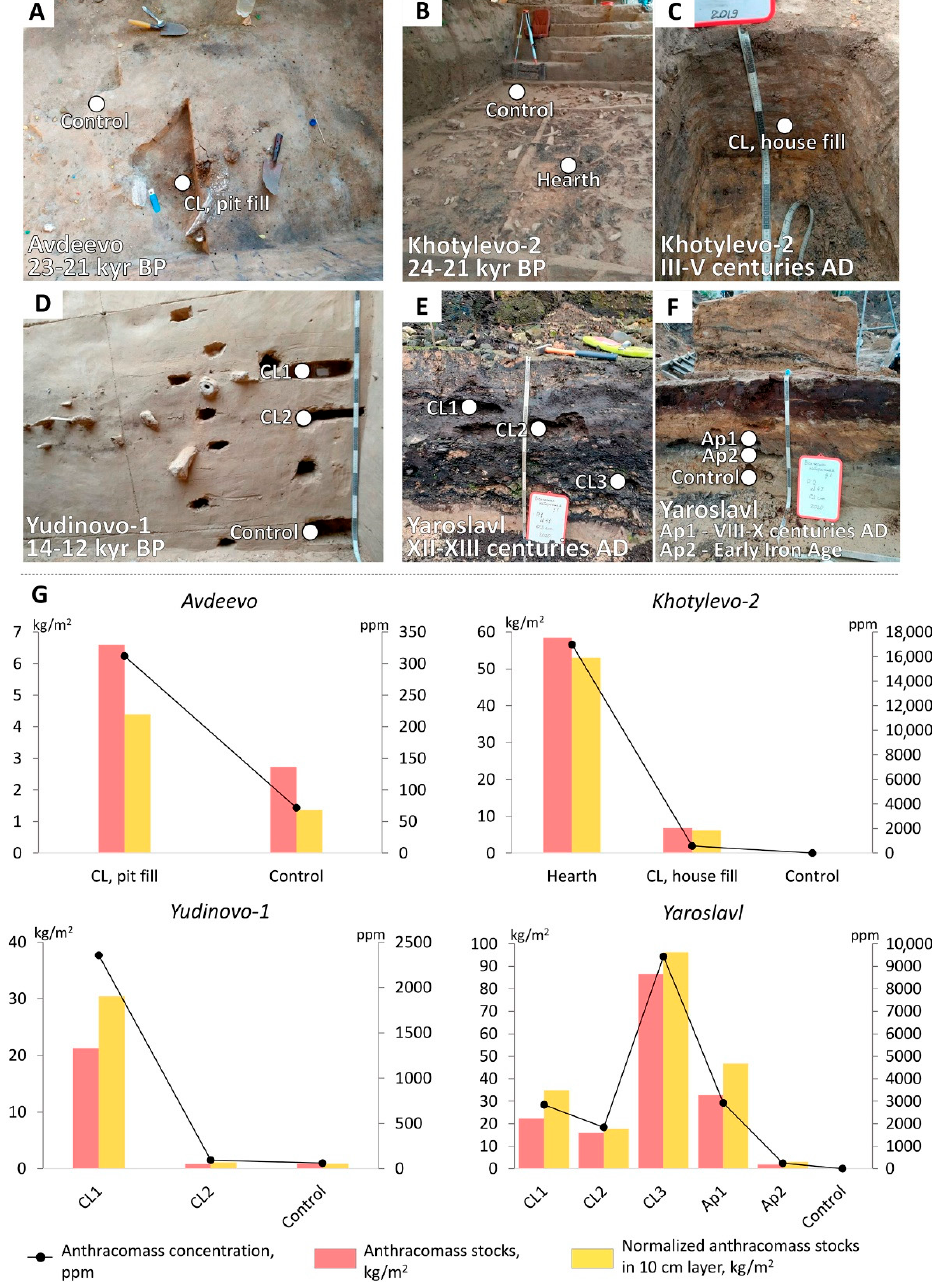
Figure 2. Anthracomass sampling locations ( A – F ) and anthracomass concentration and stocks ( G ) in the anthropogenically transformed soil horizons.